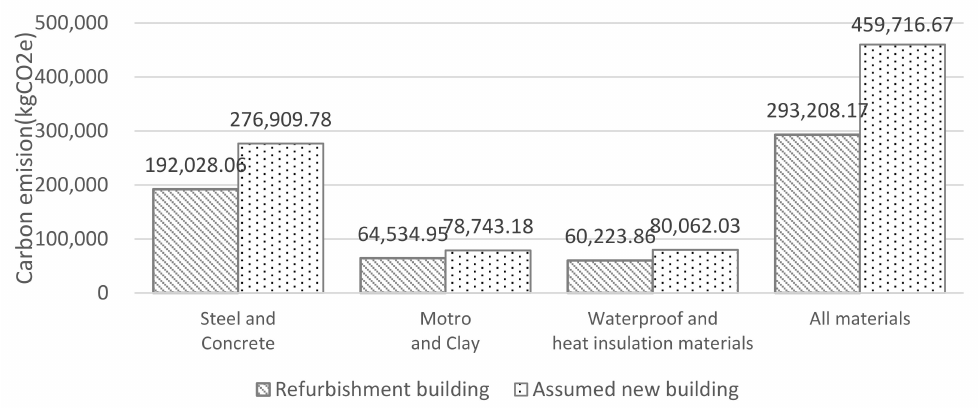
Figure 9. Carbon emission from the production of the main building materials.